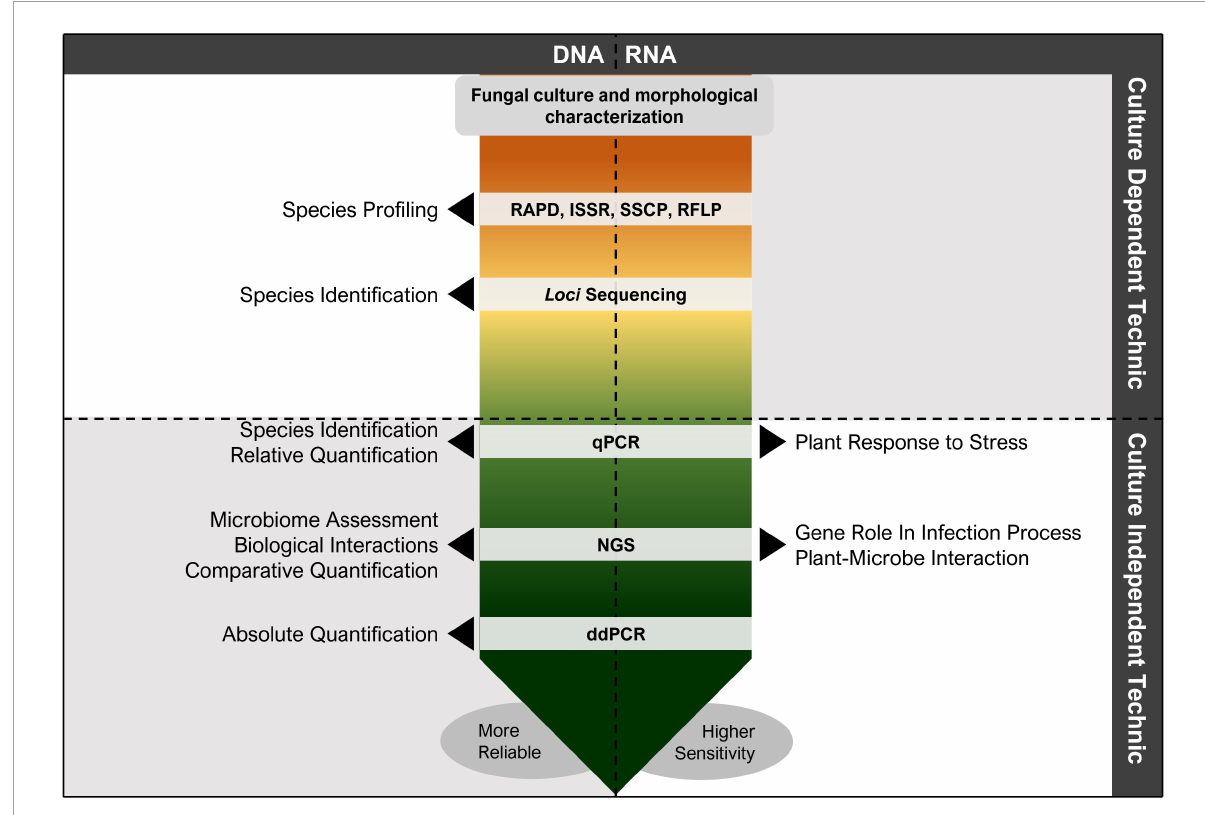
FIGURE4 Diagram indicating the most used technics for grapevine trunk disease (GTD) assessment. These technics can have several outcomes, however, can be used simultaneously to overcome the limitations of the individual techniques. Nonetheless, more protocols have been developed aiming at more reliable and sensitive GTD assessment and studies, where species can be rapidly detected and interactions between fungal pathogens, grapevine and grapevine varieties, microbiome (fungi, bacteria, and virus), and environmental conditions can be easily